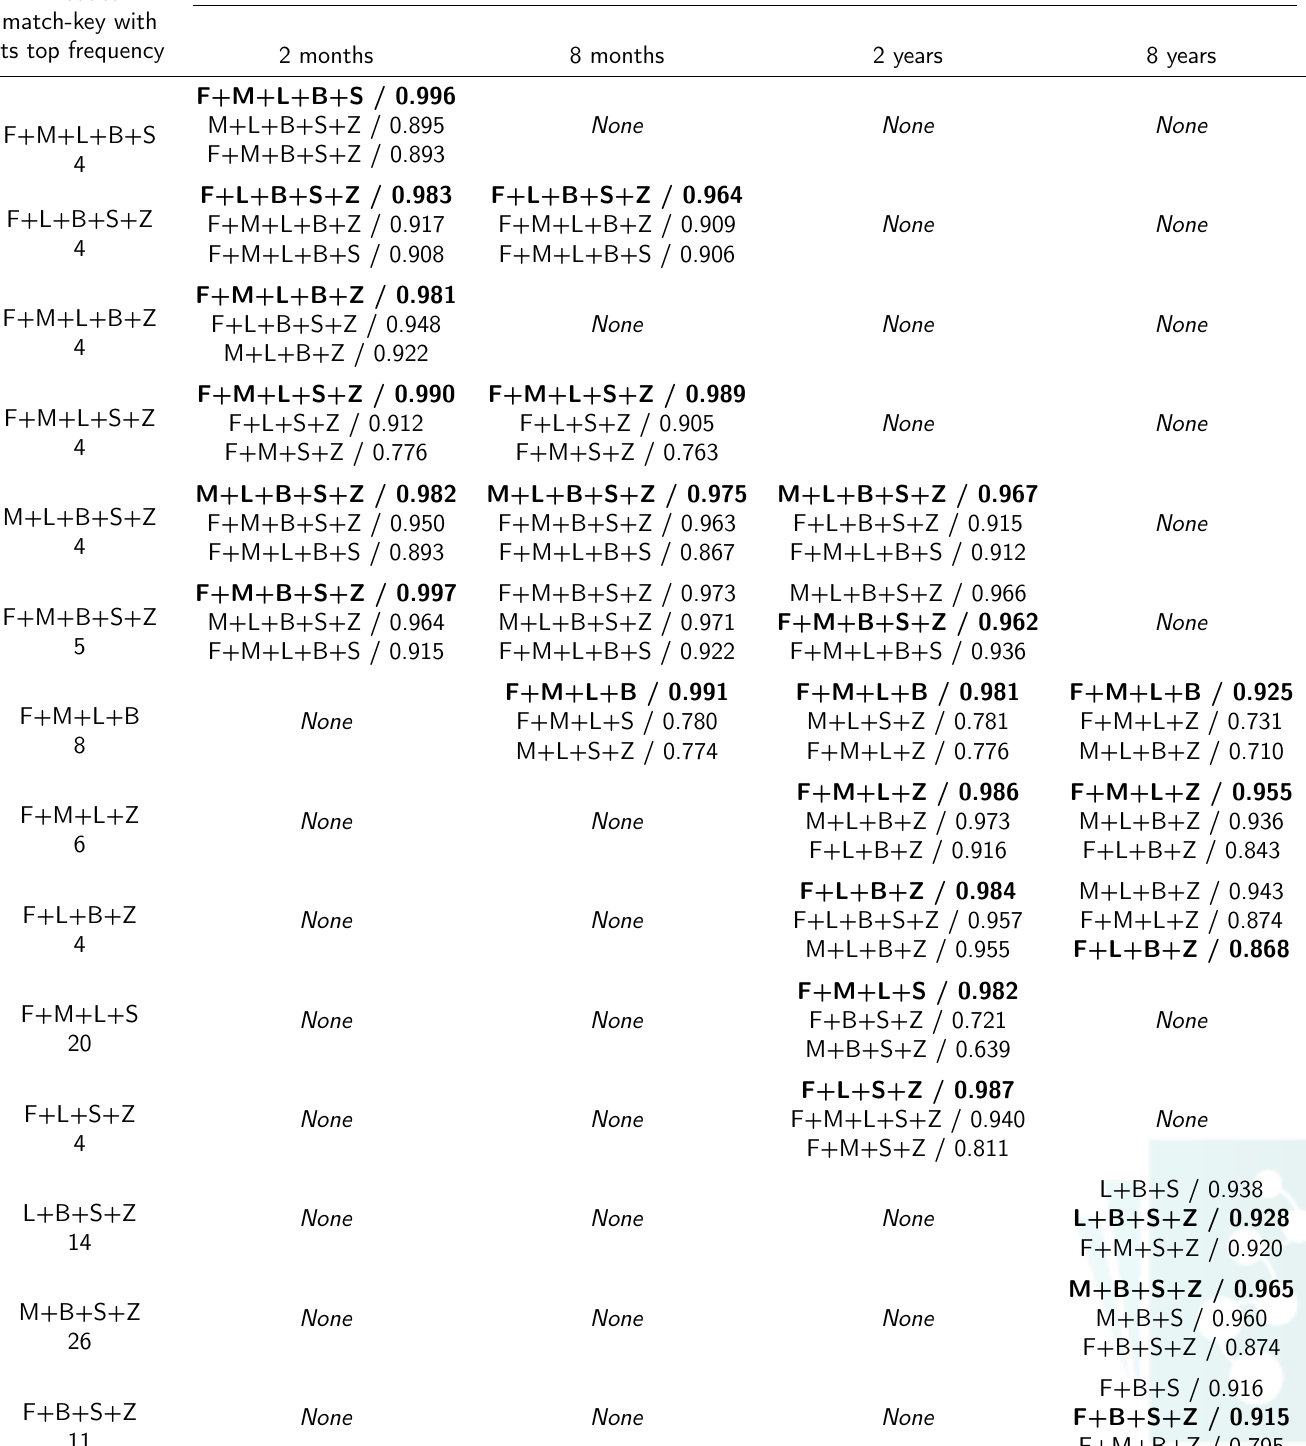
Table 4: Re-identification results of encoded match-keys for the NCVR databases with different time intervals. The attributes used are FirstName (F), MiddleName (M), LastName (L), BirthYear (B), StreetAddress (S), and ZipCode (Z). We show the top three plain-text match-keys identified for each encoded match-key and the s value of each plain-text match-key when compared with a c corresponding encoded match-key. In the left-most column we also show the maximum frequency value of the frequency distribu- tion of that match-key. The value None shows where the particular match-key is not used for the encoding of the corresponding database due to not having an overall score above w , as described in the Introduction t